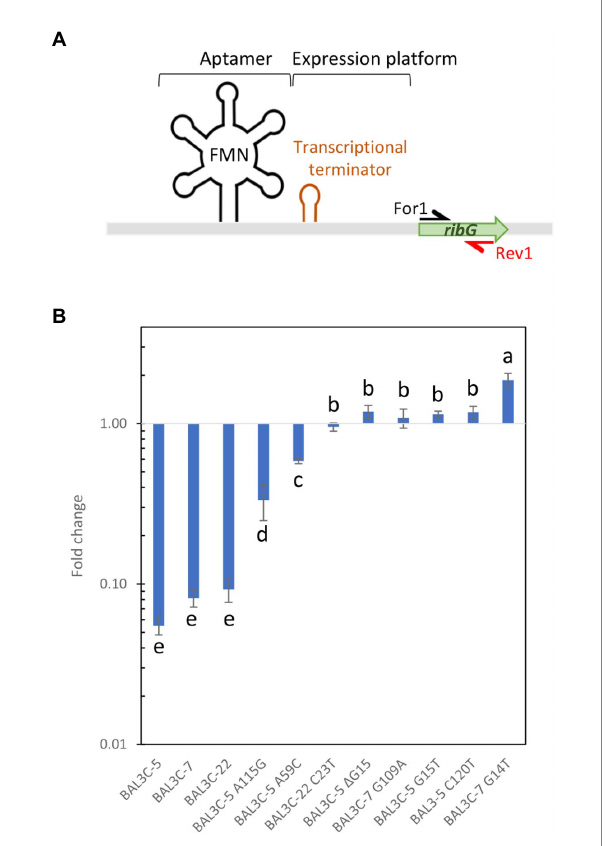
FIGURE 8 Analysis of the influence of FMN on transcription of the ribG gene in the Weissella cibaria parental and RF-overproducing strains. The bacteria were grown in RAMS and RAMS + 3 μ M FMN media and, using total RNA preparations, cDNA was synthesized and employed as substrate to perform RT-qPCR analysis. (A) Schematic representation of the rib operon riboswitch. See details in legend of Figure 7. The name and location of the primers used for the analysis are indicated. (B) The fold change of mRNA levels in the presence vs. absence of FMN are represented for each strain. Different letters mean statistically significant difference ( p ≤